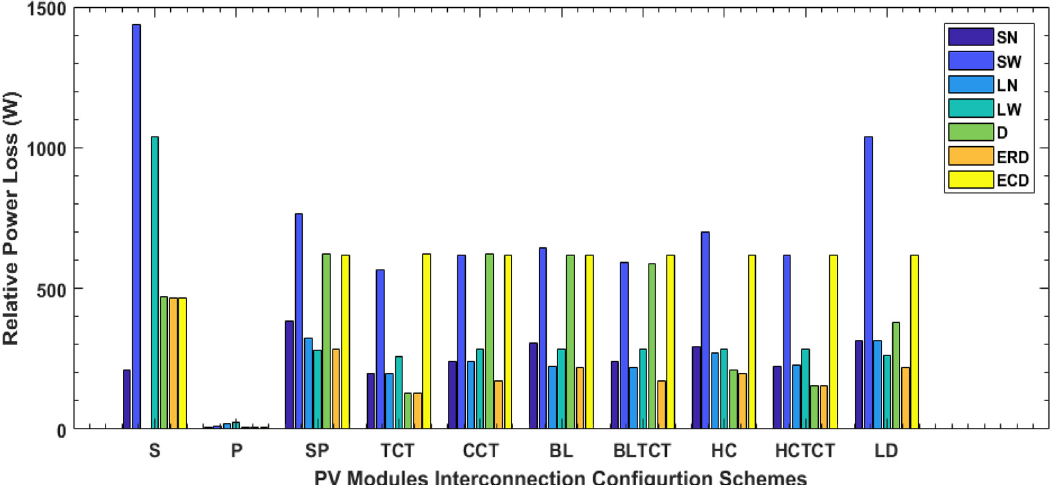
Fig. 13. Comparative illustration of relative power loss of PV modules interconnection con fi guration schemes under partial